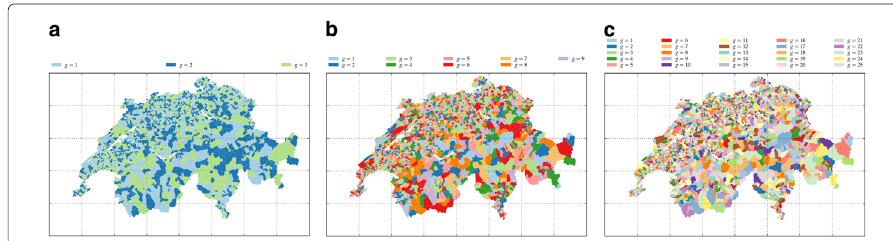
Fig. 6 The maps of the groups obtained by hard k-means clustering on the MDS over the generalised χ 2 distance between municipality profiles in the term-municipality matrix. From a to c the parameters are: m = 3, θ = 1.01; m = 9, θ = 0.5; m = 25, θ = 1.5